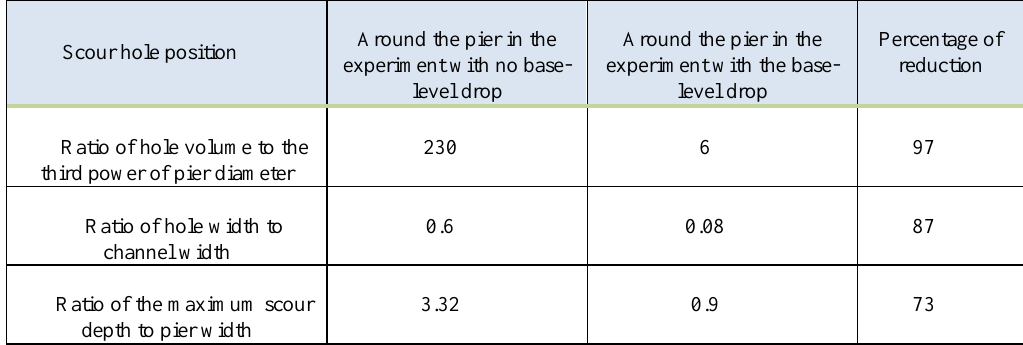
Table 1. The volume of the scour hole nondimensionalized with the third power of the pier diameter, and the width of the scour hole nondimensionalized with the channel width Around the pier in the Around the pier in the Percentage of Scour hole position experiment with no base- experiment with the base- reduction level drop level drop Ratio of hole volume to the 230 6 97 third power of pier diameter Ratio of hole width to 0.6 0.08 87 channel width Ratio of the maximum scour 3.32 0.9 depth to pier width